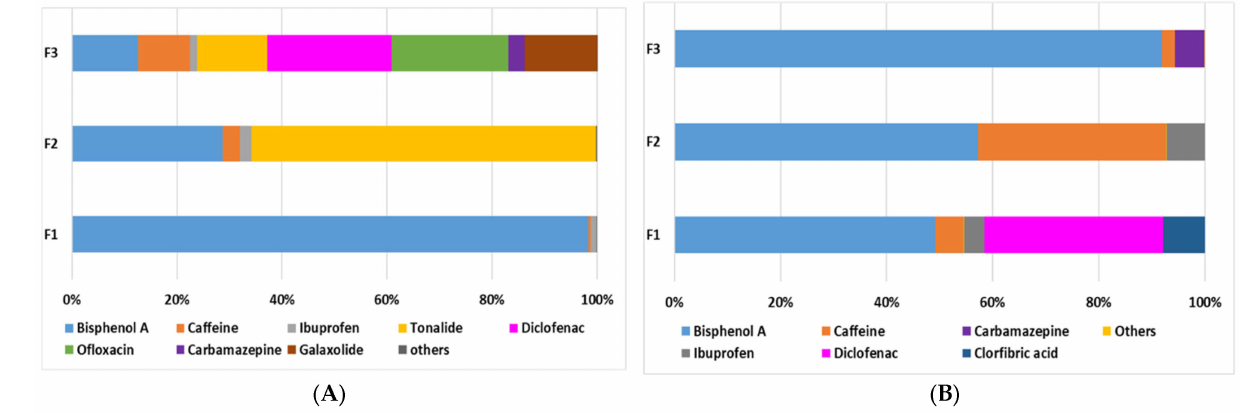
Figure 2. Relative percentage of CECs found in water ( A ) and in sediment ( B ) in F1, F2, and